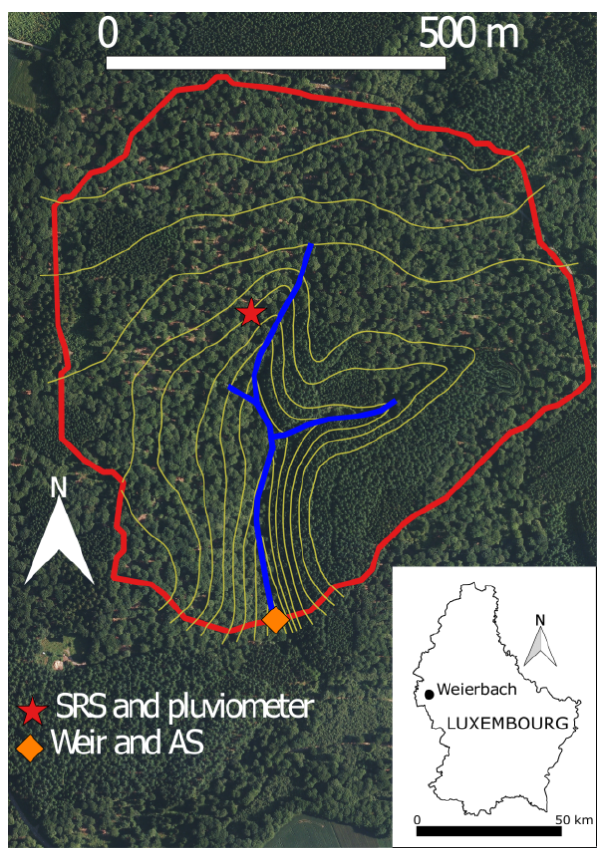
Figure 1. Map of the Weierbach catchment and its location in Luxembourg. The weir is located at coordinates (5 ◦ 47 (cid:48) 44 (cid:48)(cid:48) E, 49 ◦ 49 (cid:48) 38 (cid:48)(cid:48) N). SRS is the sequential rainfall sampler. AS is the stream autosampler. The elevation lines increase by 5m, from 460m above sea level (a.s.l.) downstream close to the weir location to 510ma.s.l. at the northern catchment